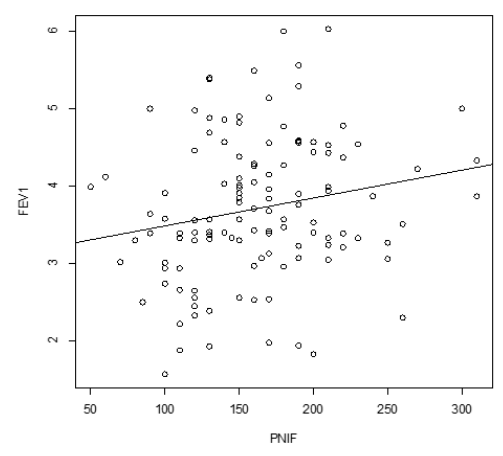
Figure 2. Correlation between FEV1 and PNIF. PNIF: peak nasal inspiratory flow; FEV1: forced expiratory volume in the 1st second.